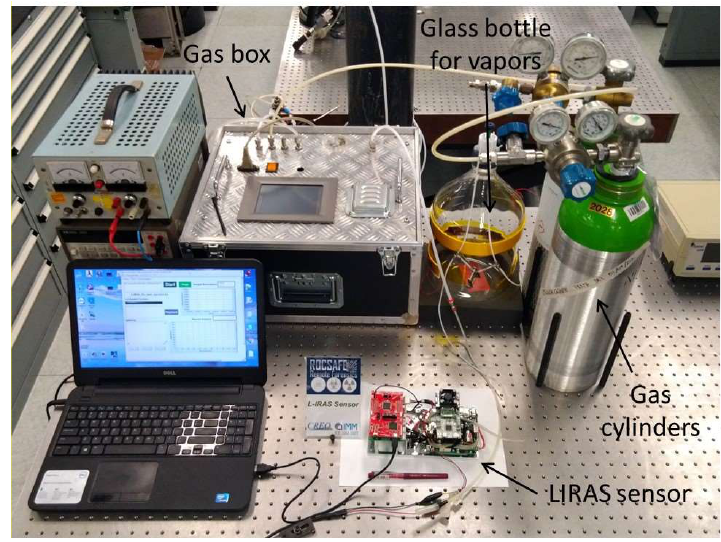
Figure 7. Laboratory setup for testing of the LIRAS sensor.